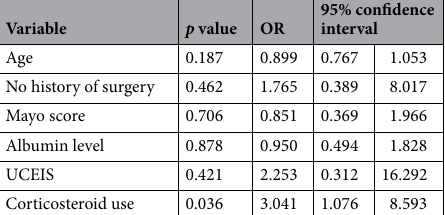
Table 5. Predictors of symptoms of anxiety and depression in UC patients. UC ulcerative colitis, UCEIS ulcerative colitis endoscopic index of severity, OR odds